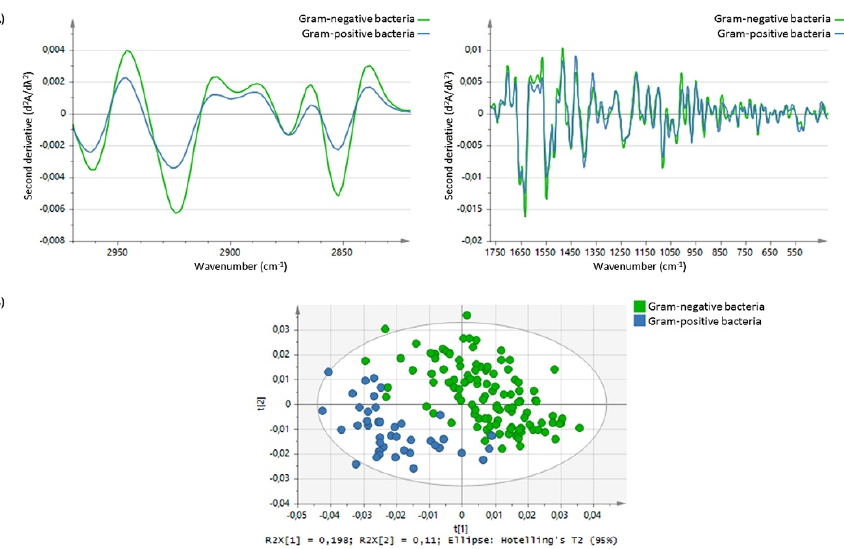
Figure 3. ( A ) Mean spectral differences in the second derivative from 2970 to 2820 cm −1 and from 1772 to 420 cm −1 between Gram-negative bacteria (green line) and Gram-positive bacteria (n = 41, blue line). ( B ) Score plot showing clustering of the Gram-negative bacteria (green dots) and Gram- positive bacteria (blue dots), based on principal component analysis in the 2970–2820 cm −1 and 1772–420 cm −1 spectral range. Picture reproduced with permission from “ Exploring the possibilities of infrared spectroscopy for urine sediment examination and detection of pathogenic bacteria in urinary tract